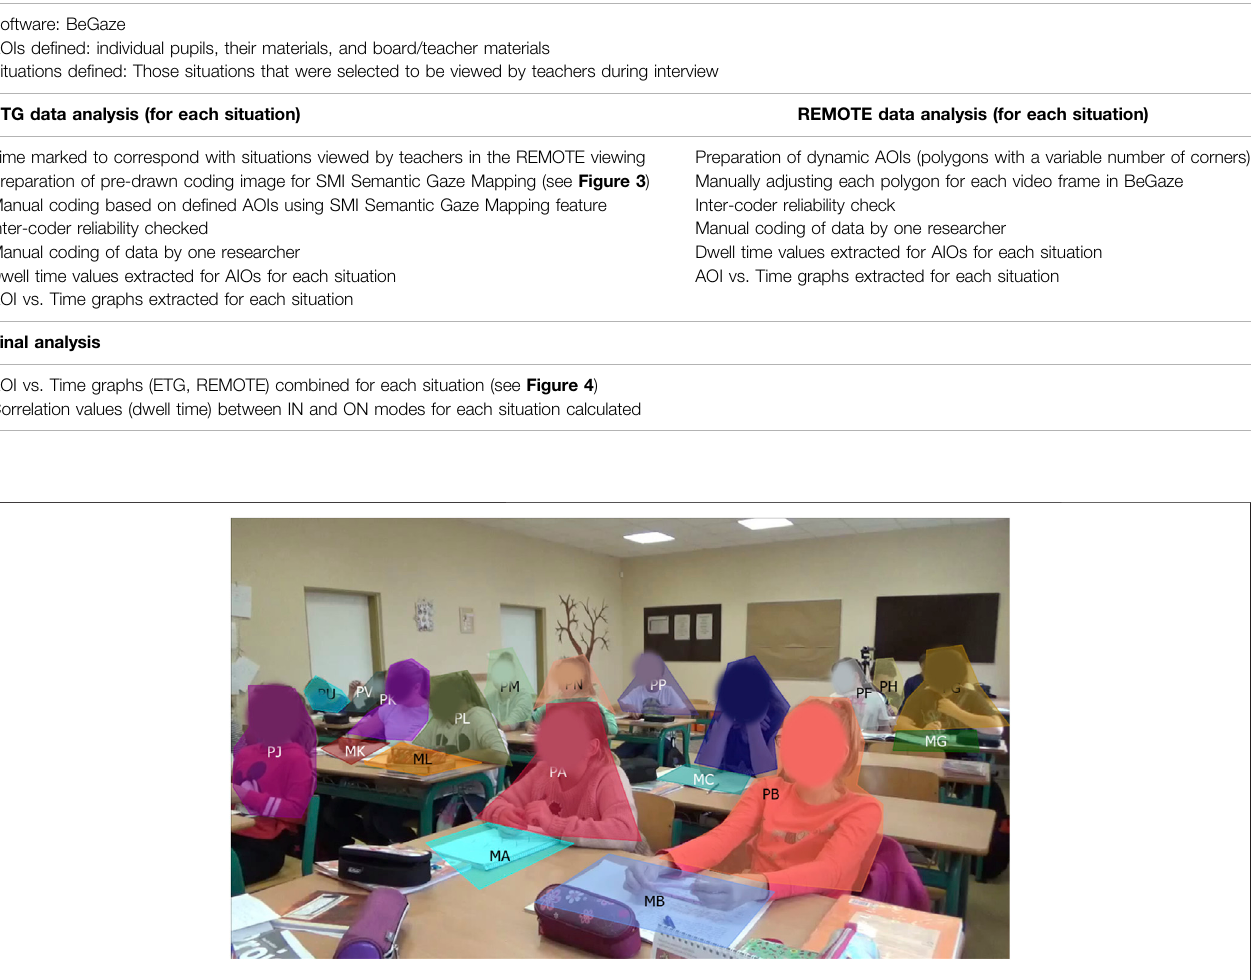
FIGURE 2 | AOIs marked in BeGaze AOI editor (T2, sequence 1; faces have been obscured for ethical